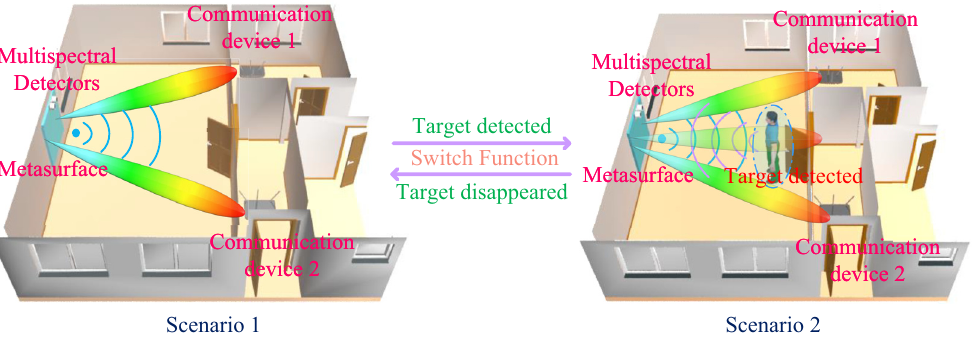
Figure 1: Schematic diagram of multispectral detection empowered adaptively reconfigurable multi-beam reflective